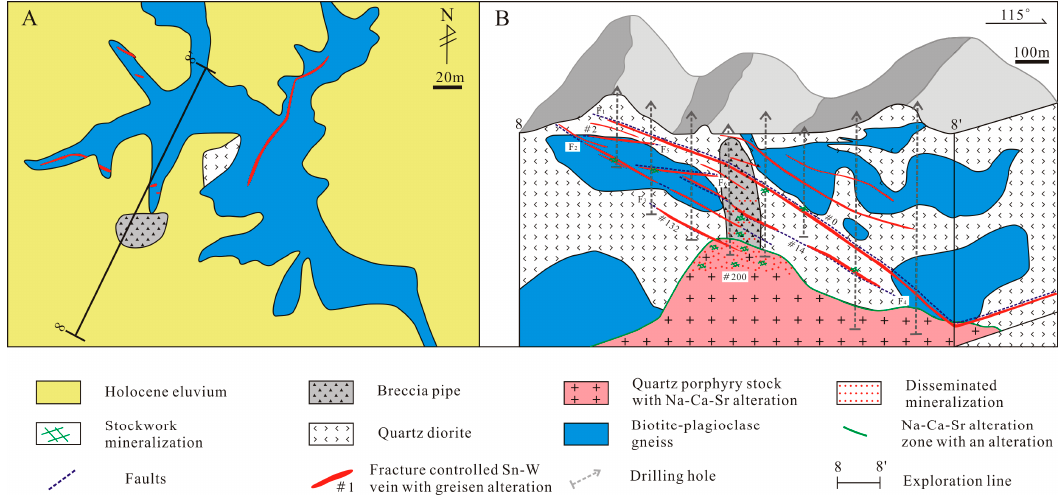
Figure 2. ( A ) Geological sketch map of the Weilasituo Sn-polymetallic deposit; ( B ) Schematic map of main orebodies of the Weilasituo Sn-polymetallic deposit (modified after [17] ).